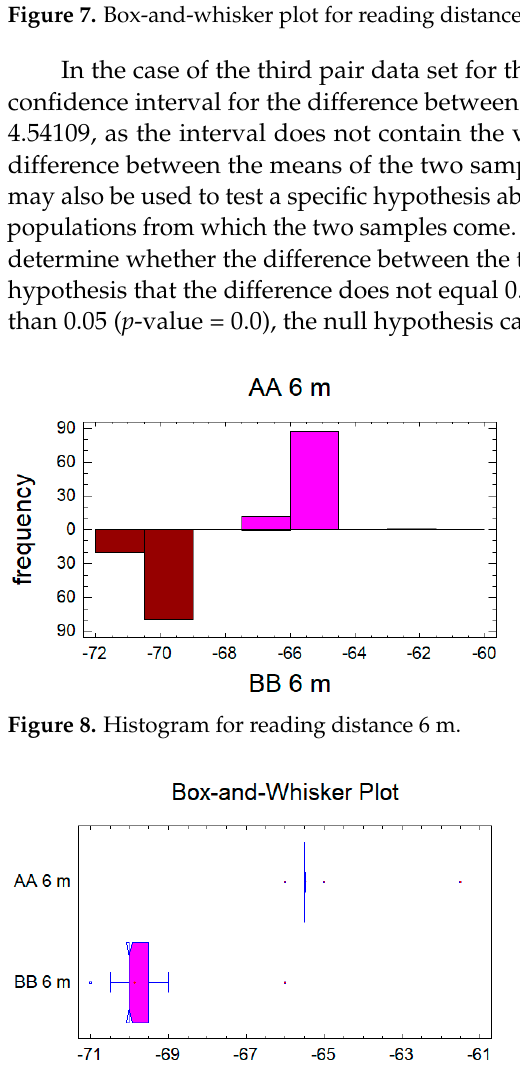
Figure 9. Box-and-whisker plot for reading distance 6 m.